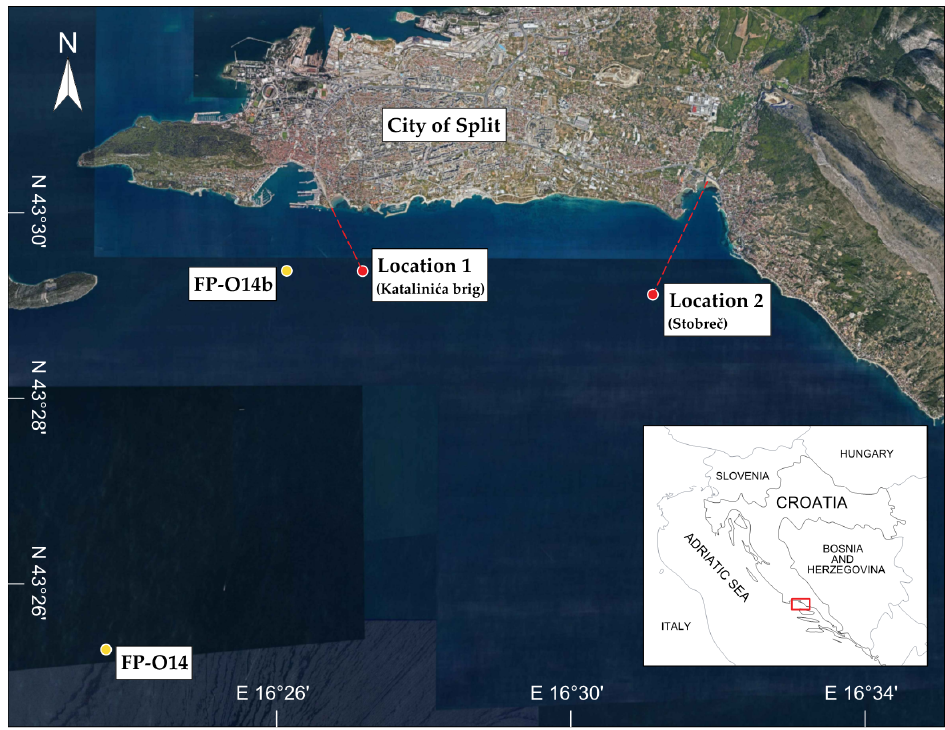
Figure 1. Locations of marine wastewater outfalls and national monitoring program stations.